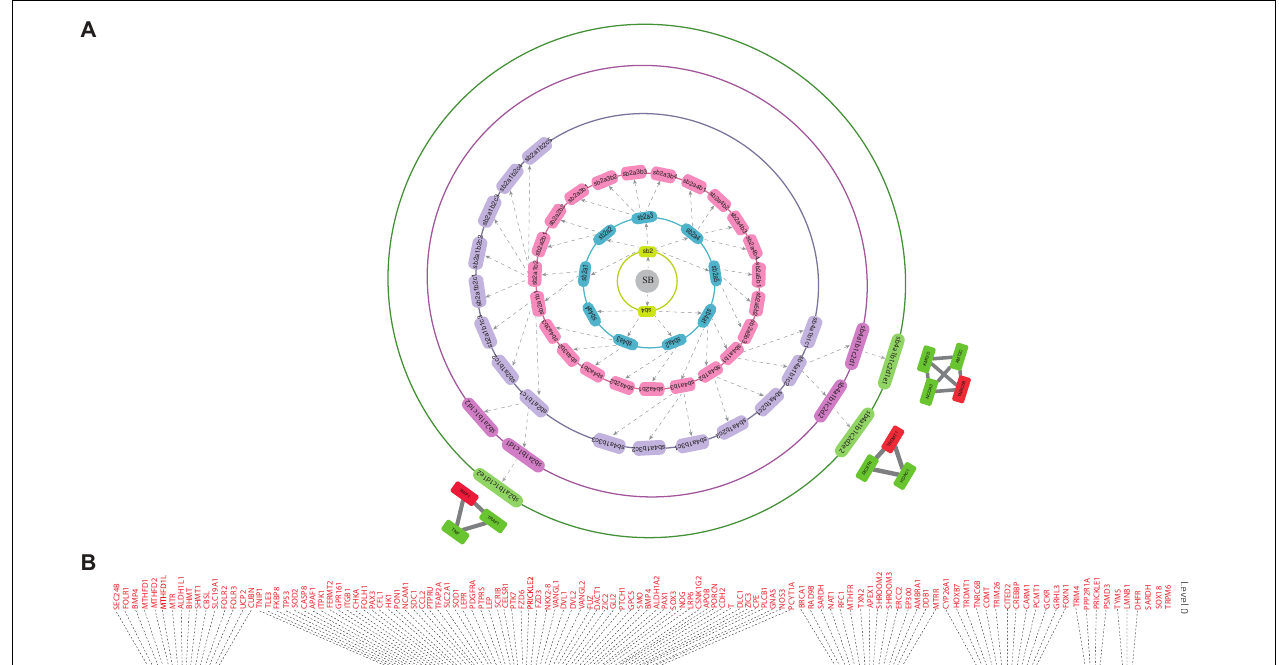
FIGURE 4 | (A) illustration of the hierarchical organization of the SB network into 6 different levels that resulted after clustering. The gray-colored circle in the center represents the primary network of SB which is level 0, the primary network got divided into seven modules after clustering making it the next level of hierarchy i.e., level 1. Each subsequent circle represents the next level of the SB network’s organization and arrows indicate submodules emerging from the previous module. (B) tracing of the seed genes through different hierarchical levels of the SB network starting from the main network (SB) i.e., level 0 up to the motif level i.e., level 6.